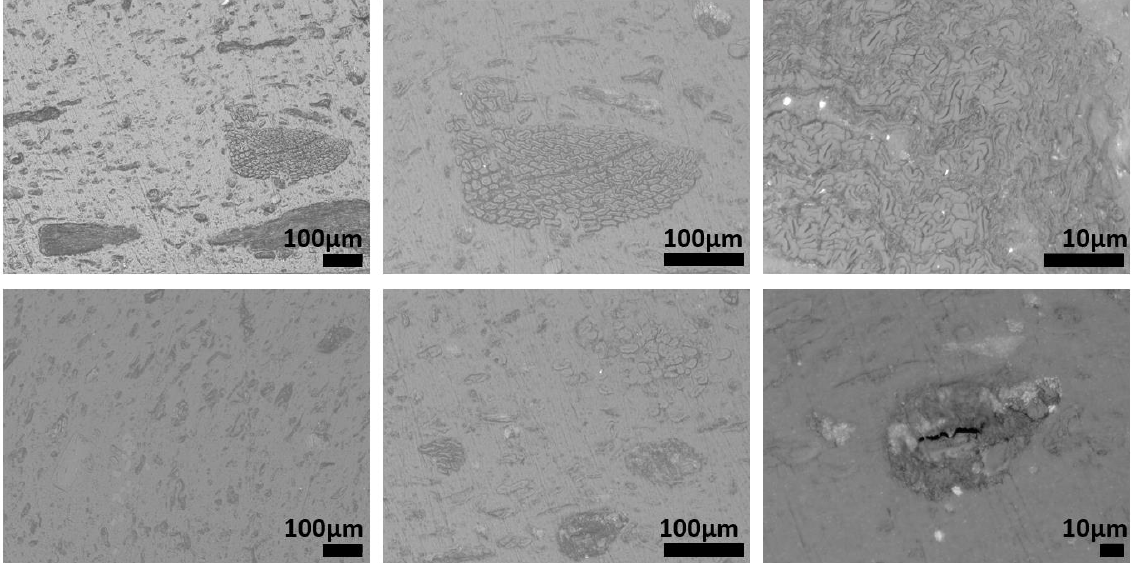
Figure 8. Microstructure of specimens produced using recovered PE.